Question: Provide a one-line summary of what is displayed.
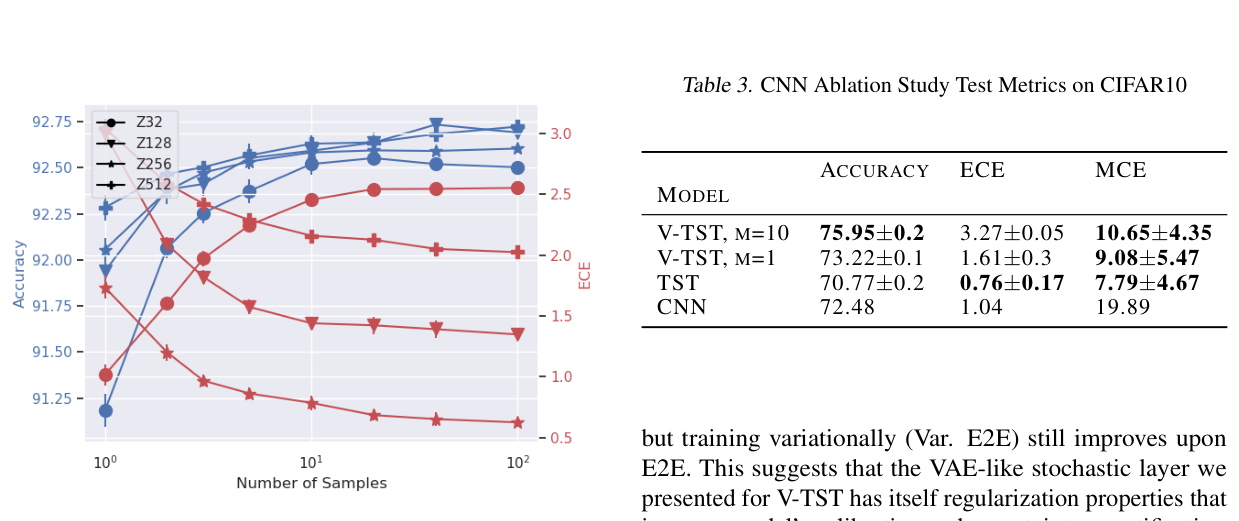
Answer: Effect of number of samples in Monte Carlo approxima- tion during test evaluation of Eq(z|x) [p(y|z)] in V-TST trained models on CIFAR10.